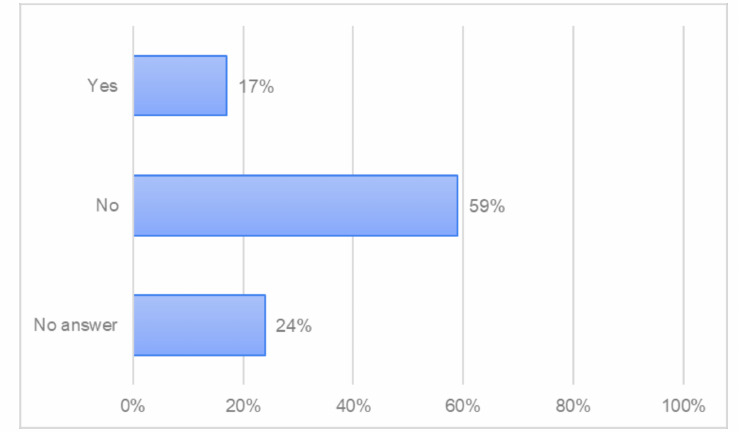
Figure 12. Summary of accidents to tree climbers at climbing/descending from the tree crown.